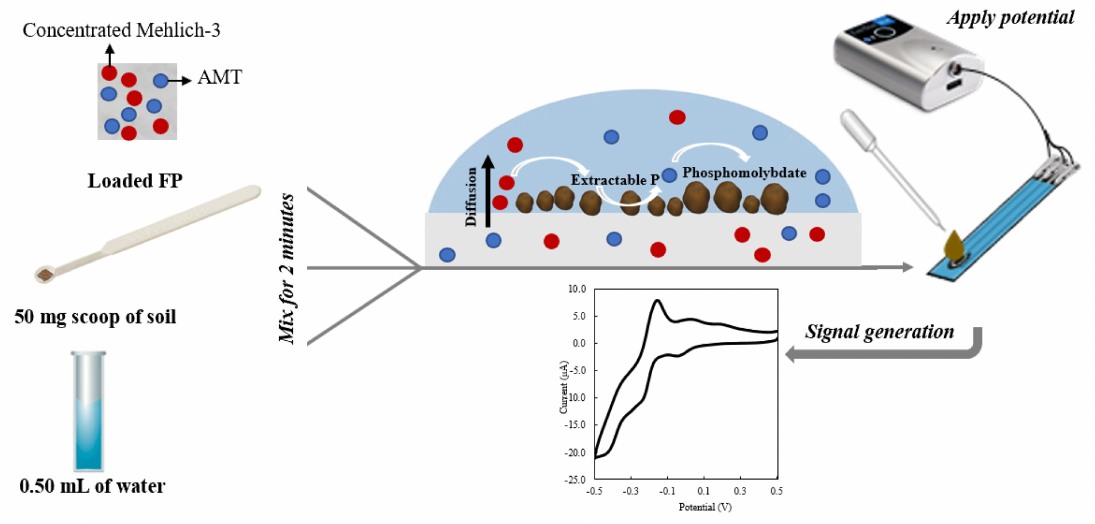
Figure 2. Setup scheme for soil phosphate analysis using ERR